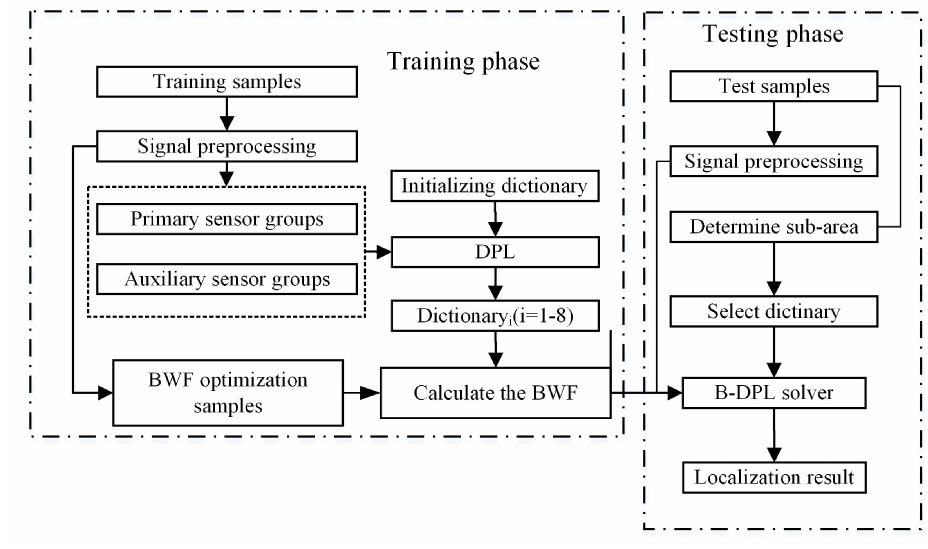
Figure 9. Flow chart of the localization